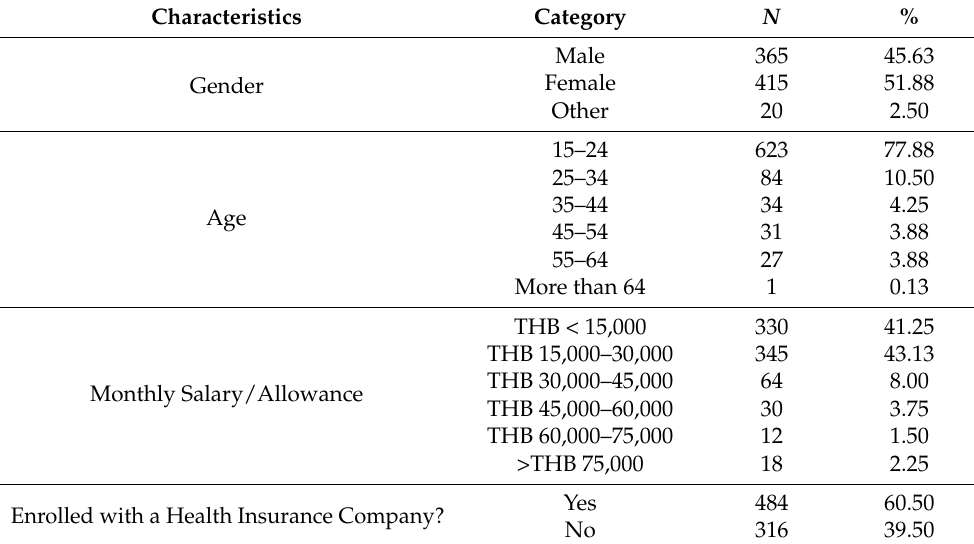
Table 2. The demographic profile of the respondents ( N =